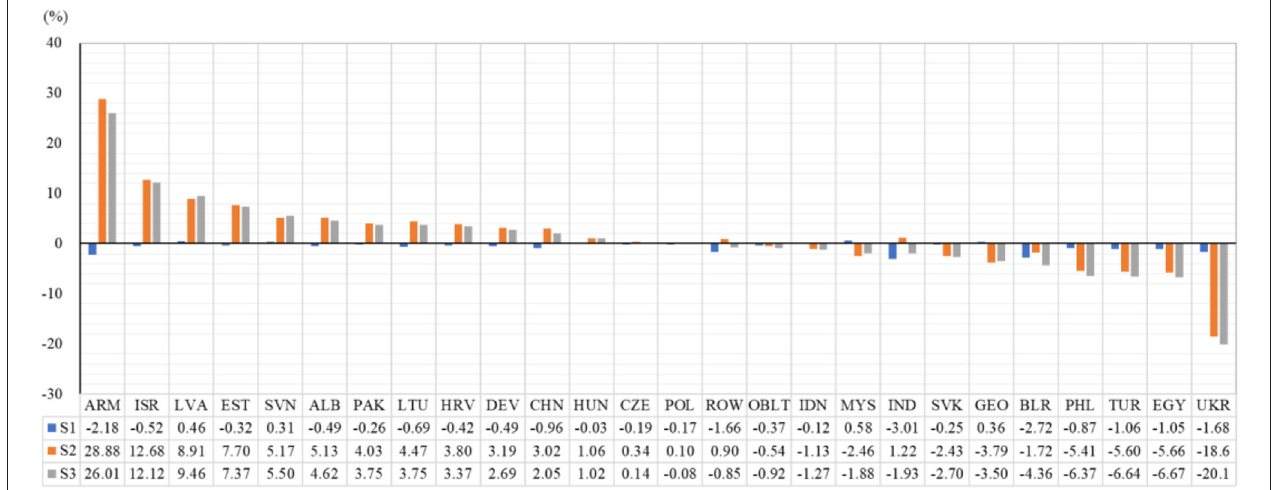
FIGURE 1 | Changes in the output of the digital industries under the three simulation scenarios (unit: %). Data sources: GTAP model